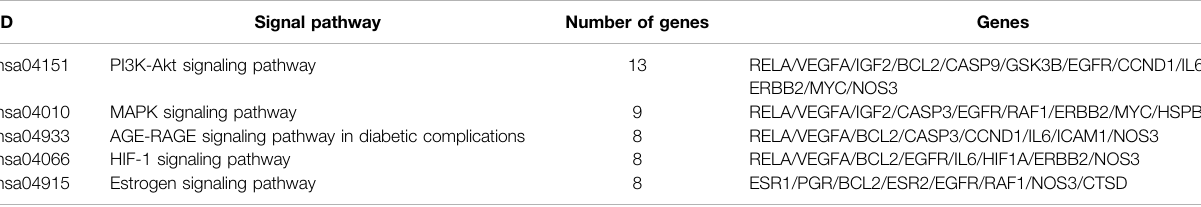
TABLE 2 | Signal pathway with KEGG target number ≥ 5 of Xihuang pills